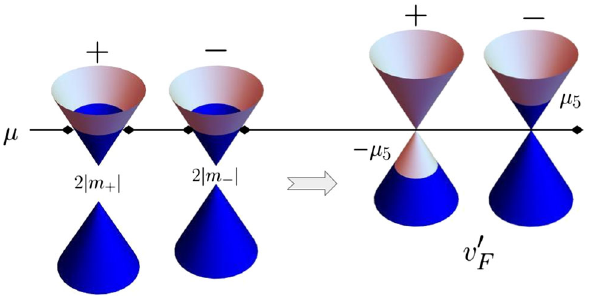
Fig. 8 Schematic description of the new Dirac cones considering charge carriers propagating near the Fermi surface, considering a new average Fermi velocity for both